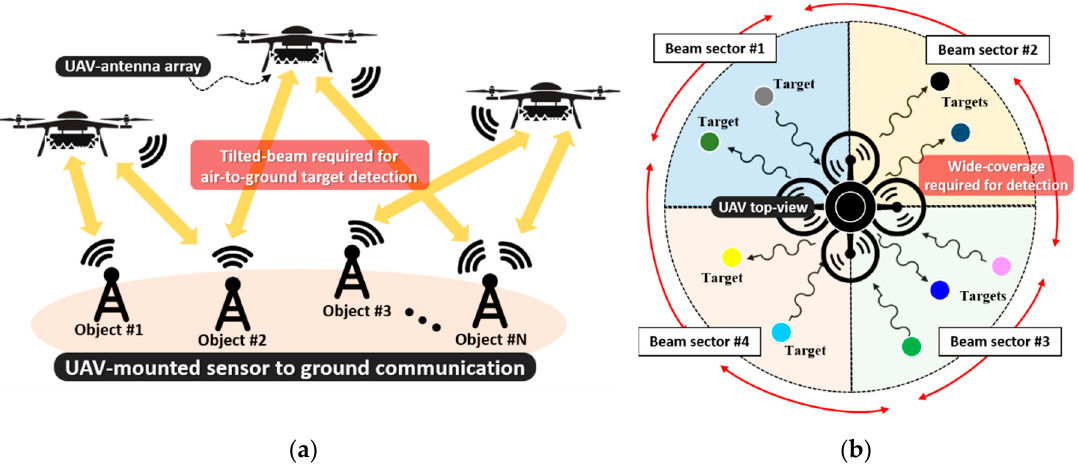
Figure 1. Required optimal antenna performance for unmanned aerial vehicle (UAV)-mounted sensor applications: ( a ) tilted beam for air-to-ground communication and ( b ) 360 ° beam coverage around UAV for target detection.